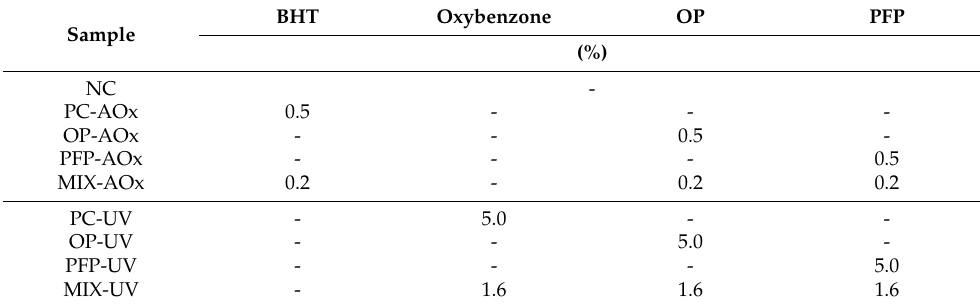
Table 6. Percentage of additives added to the nine formulations